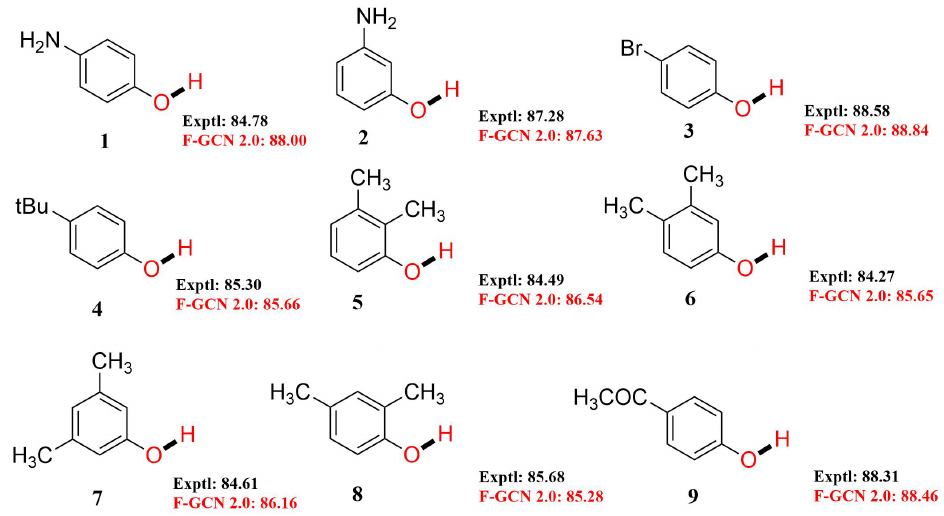
Figure 8. Comparison between the experimental and predicted O-H BDEs (in kcal/mol) of the selected phenol